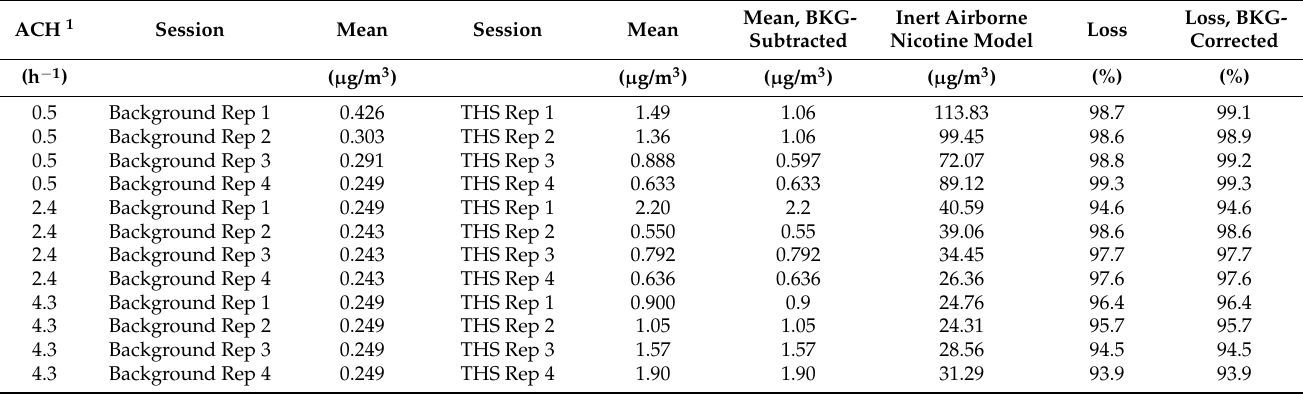
Figure 10. Histogram of MLE (mg nicotine/stick) distribution measured over all brands. H bars represent the range (min–max) covered by machine puffing of the tobacco sticks under the respective regimens described in Supplementary Materials, Table S14. Table 3. Estimated loss of nicotine (sum of nicotine levels retained by the panelists and those adsorbed on surfaces) during individual THS 2.2 sessions, based on measured airborne nicotine concentrations (with and without background subtraction) and the inert airborne nicotine model (calculated from the measured MLE values).